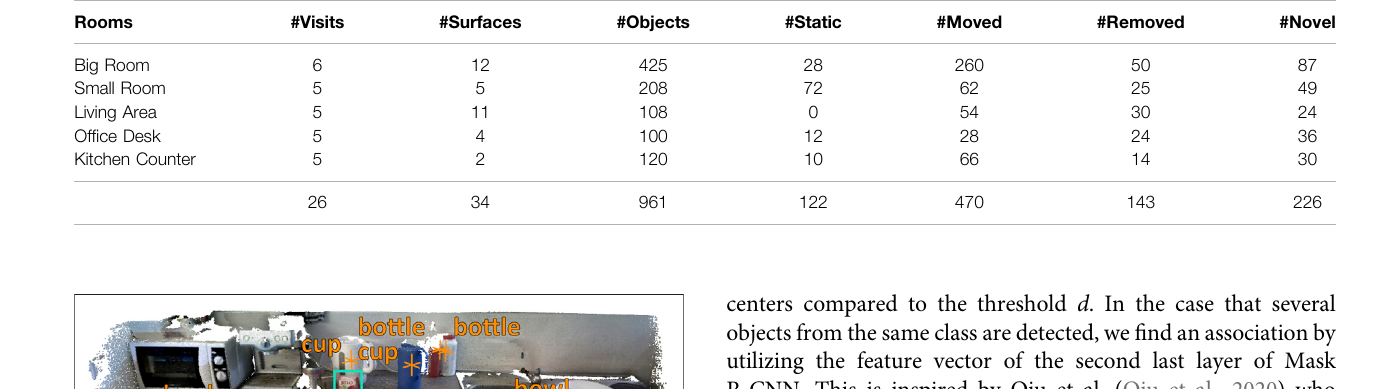
TABLE 3 | Overview of the dataset used for the quantitative evaluation. Except for the fi rst two columns the numbers state the sum over all possible comparisons per room.